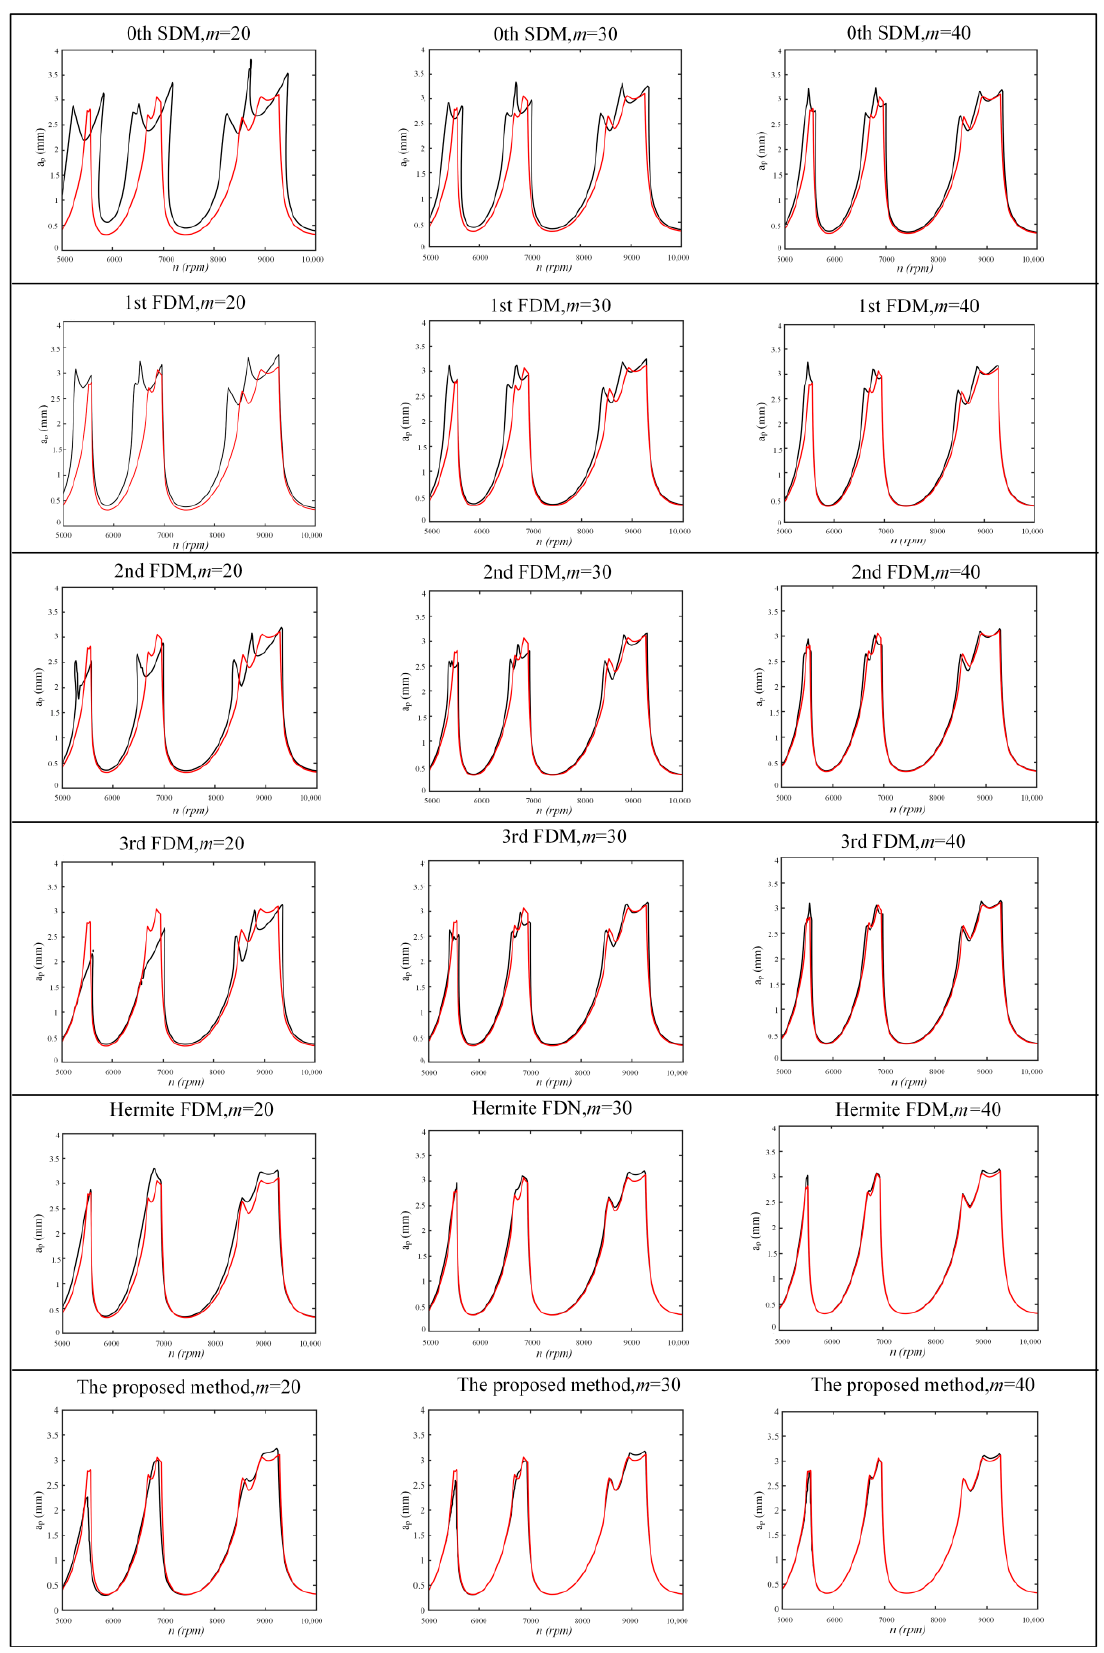
Figure 3. A comparison of computational accuracy in a/D = 1.